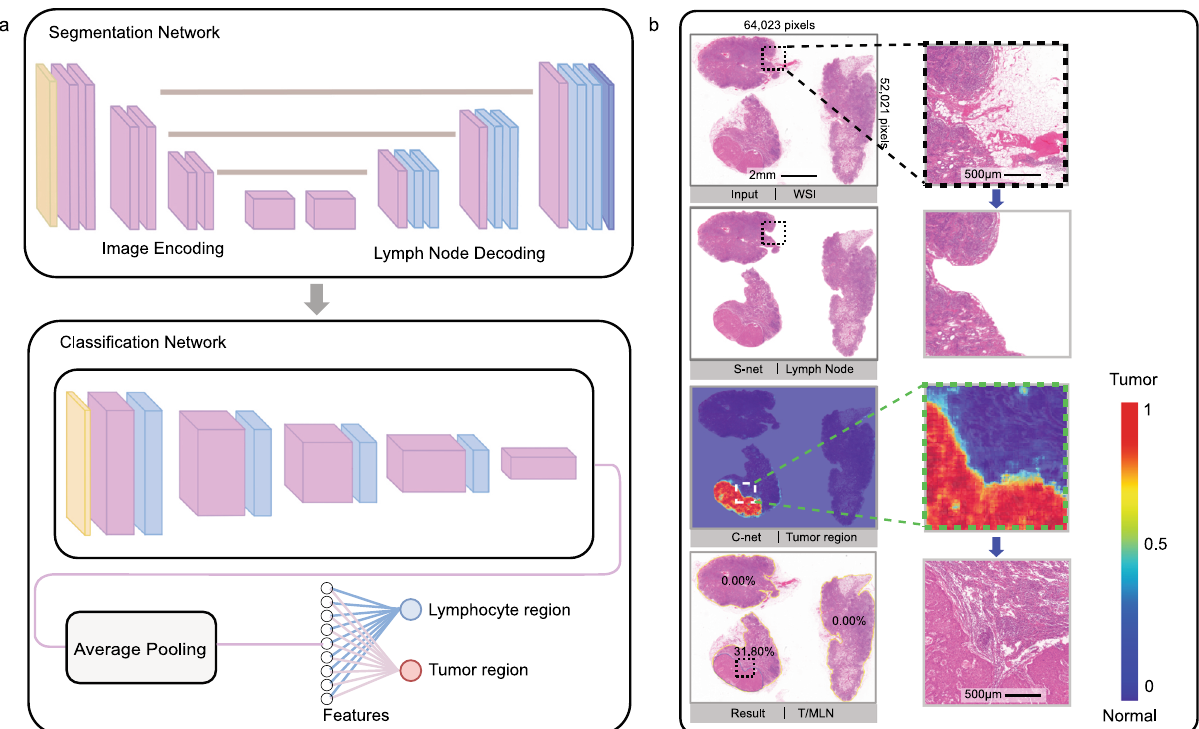
Fig. 2 Deep-learning framework. a Slide analysis work fl ow. b Representative slide identi fi ed by deep learning. The slide is fi rst input into the segmentation network to extract the lymph node region and remove tissues such as fat and muscle outside the lymph node. The tissues in the lymph node region are then classi fi ed by the classi fi cation network to identify the tumor region. The area ratio of tumor metastatic lymph nodes (T/MLNs) is fi nally calculated based on the